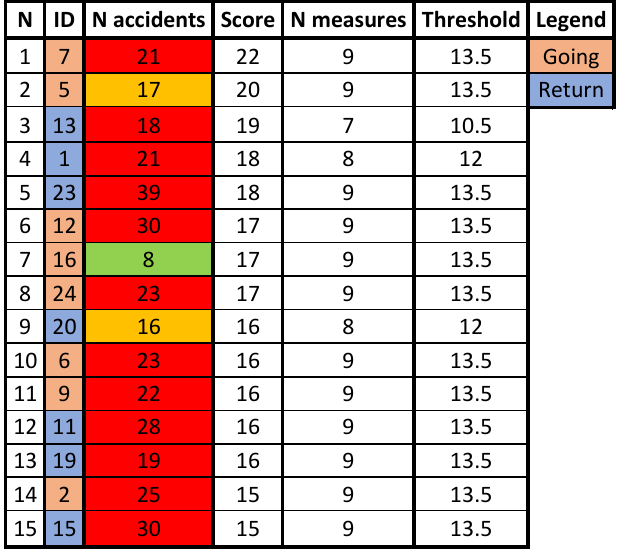
Figure 14. The 15 areas with the highest stress scores. The areas identified with high accident rates according to road safety analysis are reported in red. The colors yellow and green identify zones with medium-high and medium-low accident rate.